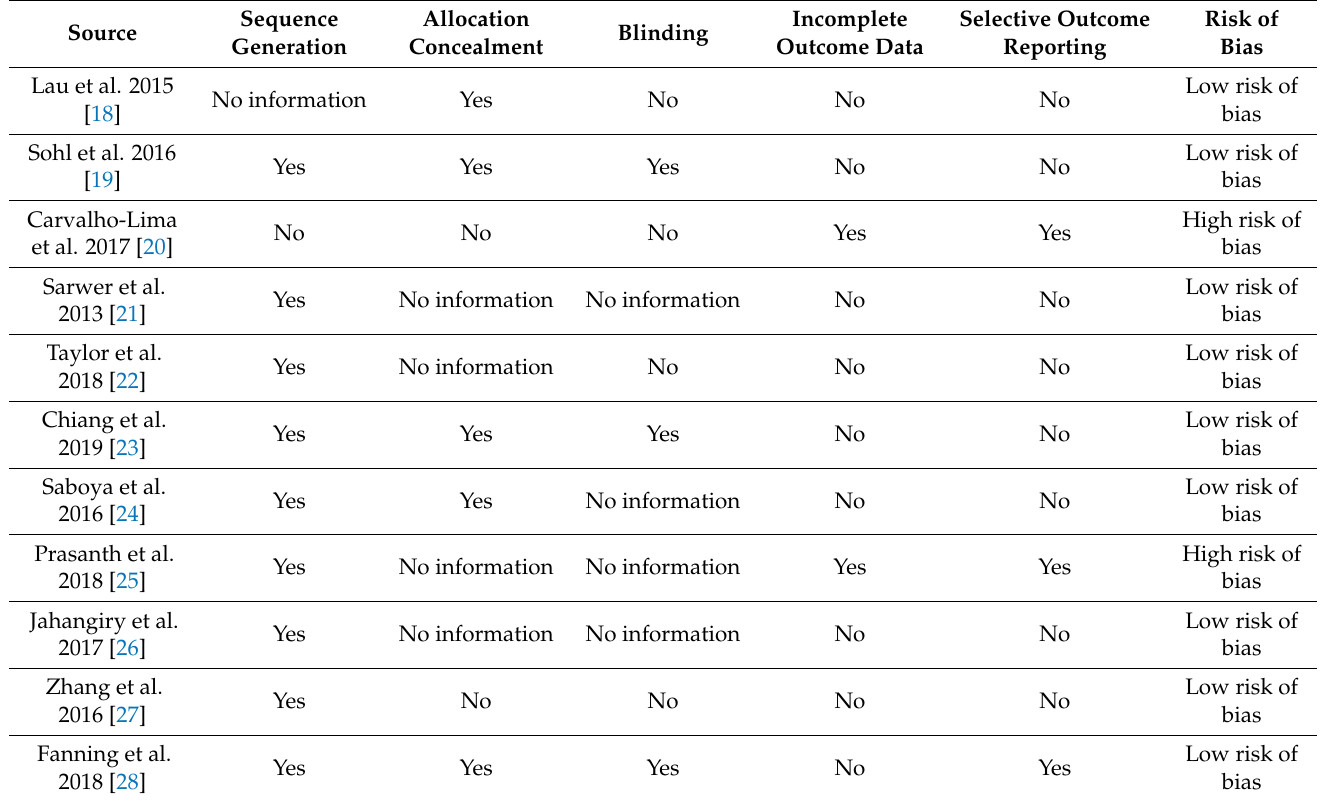
Table 1. Quality measures of the randomized controlled